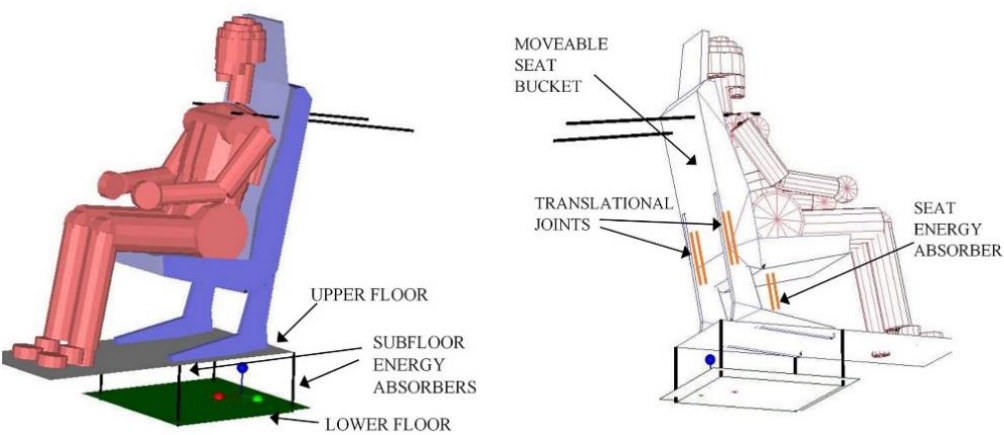
Figure 3. Lumped mass model of the specimen, with an anthropomorphic test dummy (ATD), a crashworthy seat and a subfloor.